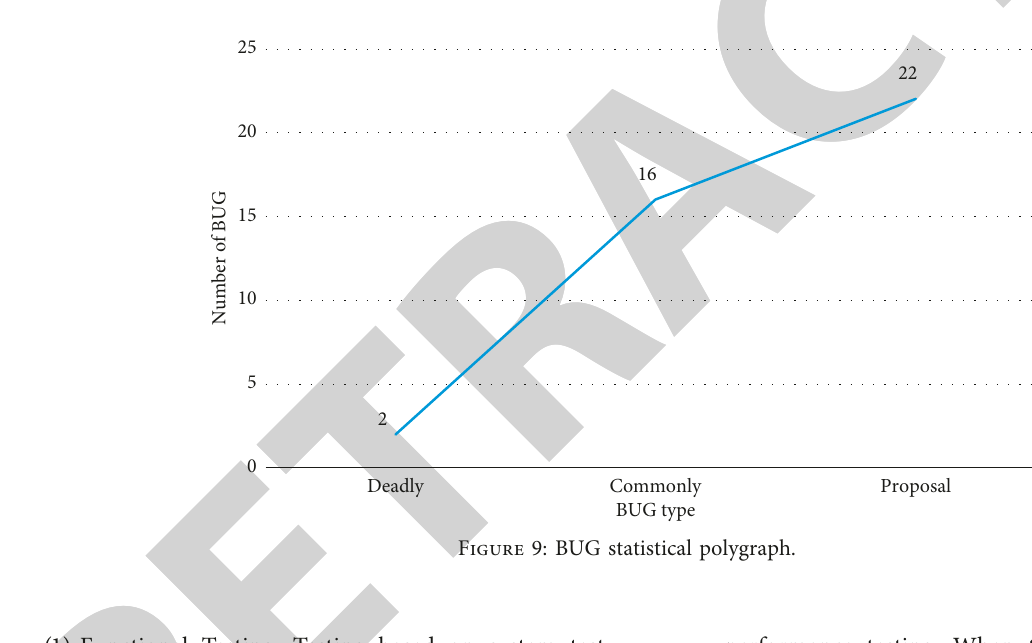
Figure 8: Report analysis interface diagram.